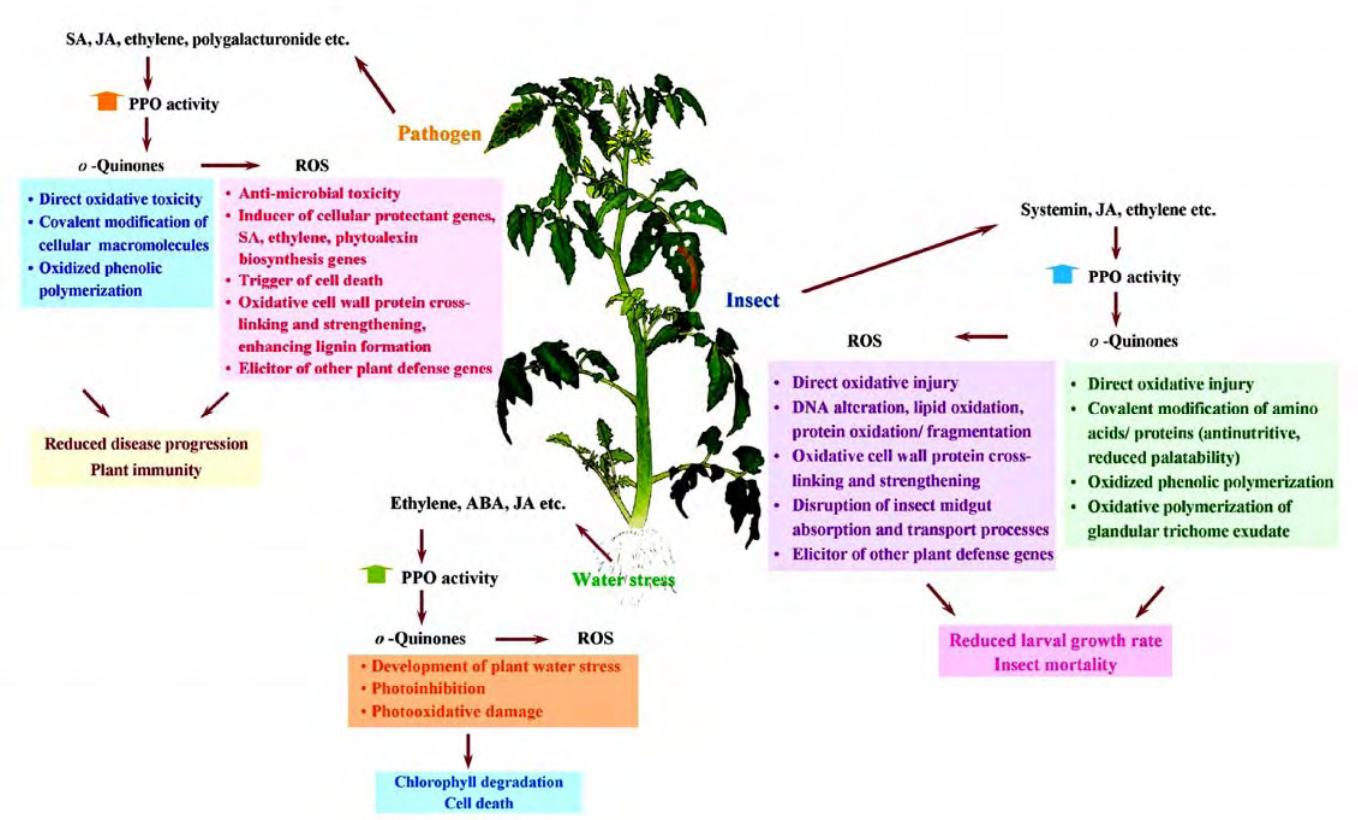
Figure 5. Hypothetical mechanisms of action of tomato PPO in response to pathogen infection, insect infestation and water